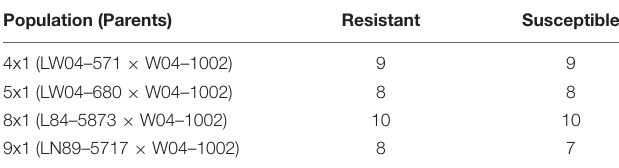
TABLE 2 | Number of most resistant and susceptible lines in each population from 2013 Sclerotinia stem rot greenhouse evaluations used for performing SNP marker analysis.